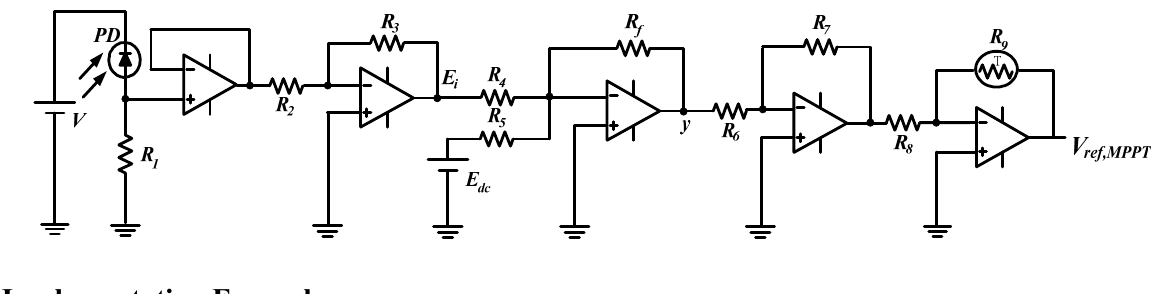
Figure 8. The proposed DLAA circuit to determine a voltage command achieving MPPT with analog